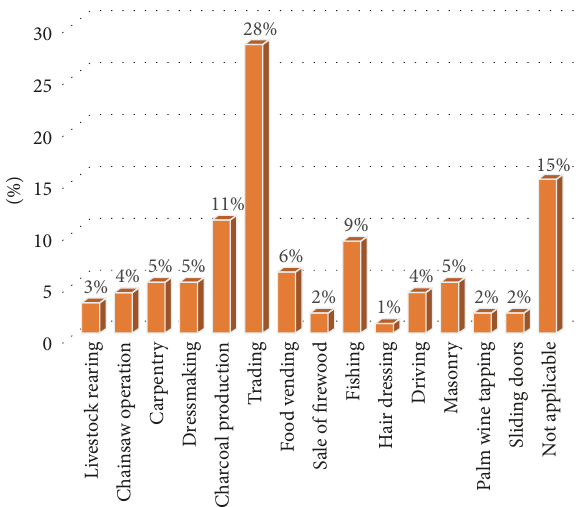
Figure 2: Alternative income generating